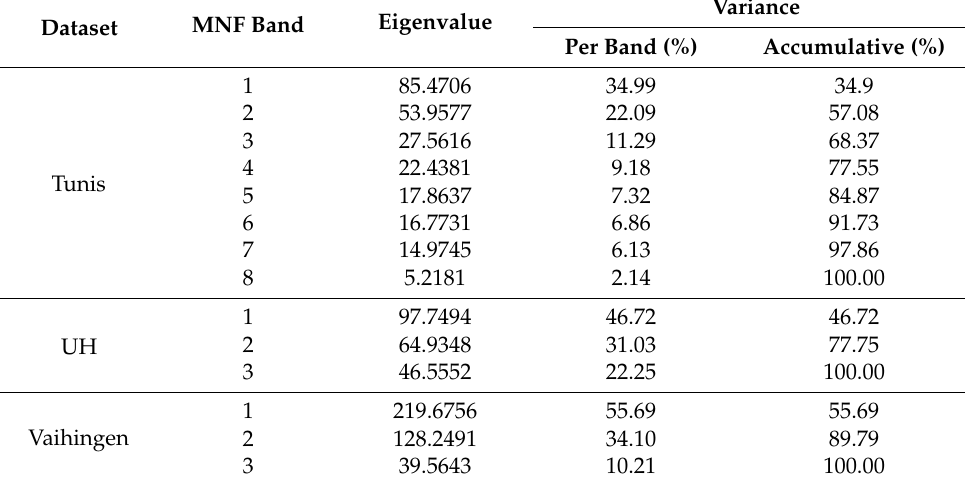
Table 8. Statistics of MNF bands.